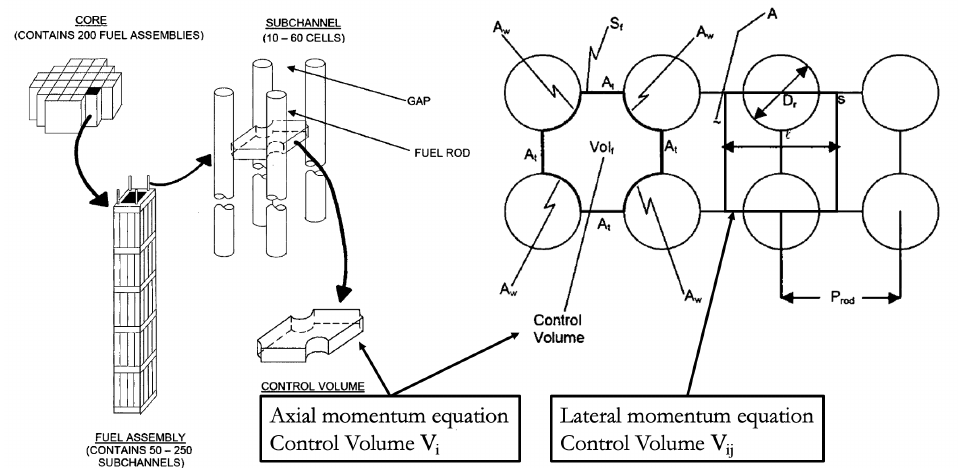
Figure 1. Square lattice subchannel control